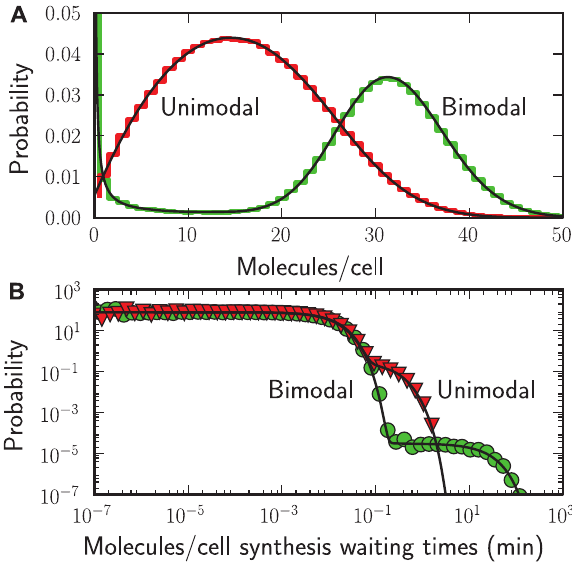
Figure 5. mRNA copy number and event waiting times distributions. StochPy plots of simulating stochastic gene expression with StochPy simulations (step, markers, colored) and analytical solutions (solid, black). (A) probability distribution of the mRNA copy numbers. (B) probability distribution of the mRNA synthesis event waiting